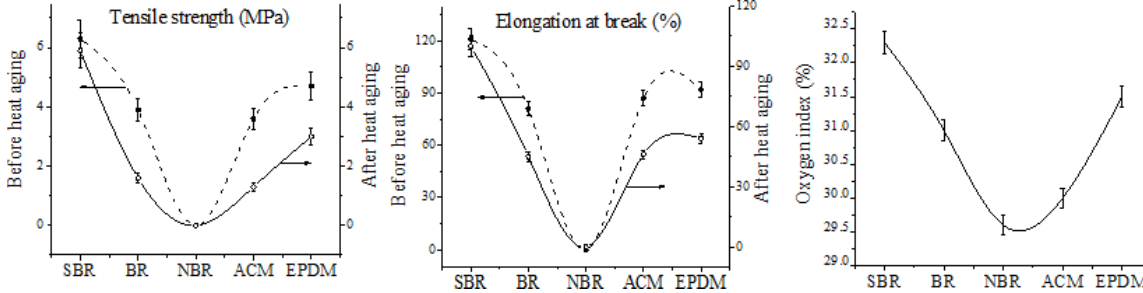
Figure 1: Mechanical properties and the oxygen index of various rubber filled DMC/MVQ composites (DMC/rubber/MVQ = 50/20/80).